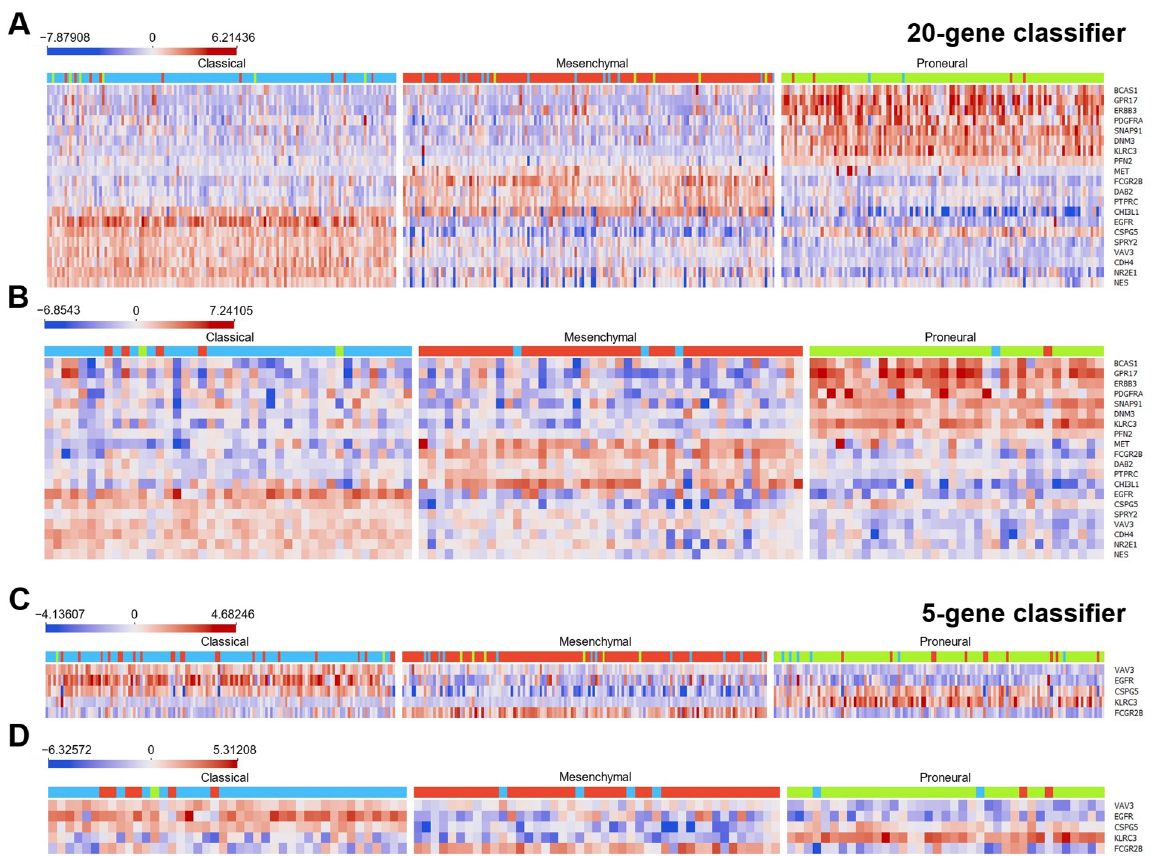
Figure 4. The heatmaps of selected glioblastoma classification genes panels. Blue, red, and green indicators above each heatmap show predicted classical, mesenchymal, and proneural subtypes, respectively. Each color discrepancy in the indicators means sample misclassification with reference to the Verhaak subtype. Data in the heat map are ordered after hierarchical bi-clustering. Parts ( A , B ), accordingly, represent data from Affymetrix HT and Illumina HiSeq cohorts applying a 20-gene classifier and parts ( C , D ) applying a five-gene classification of the same cohorts,